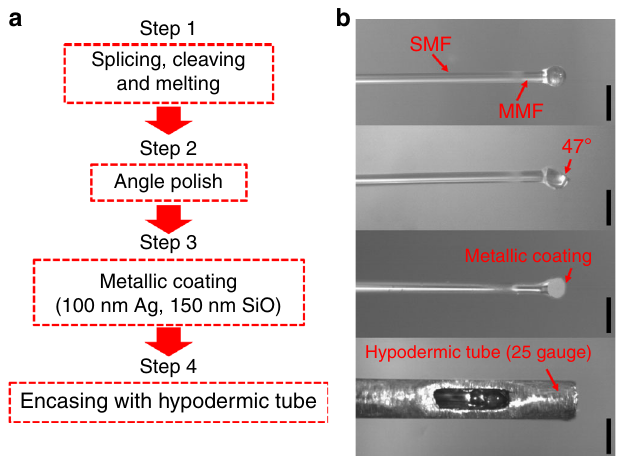
Fig. 8 Fabrication procedures. a Flow chart for microprobe fabrication. b Representative photographs of the fi ber probe corresponding to each fabrication step shown in a . All scale bars are 500